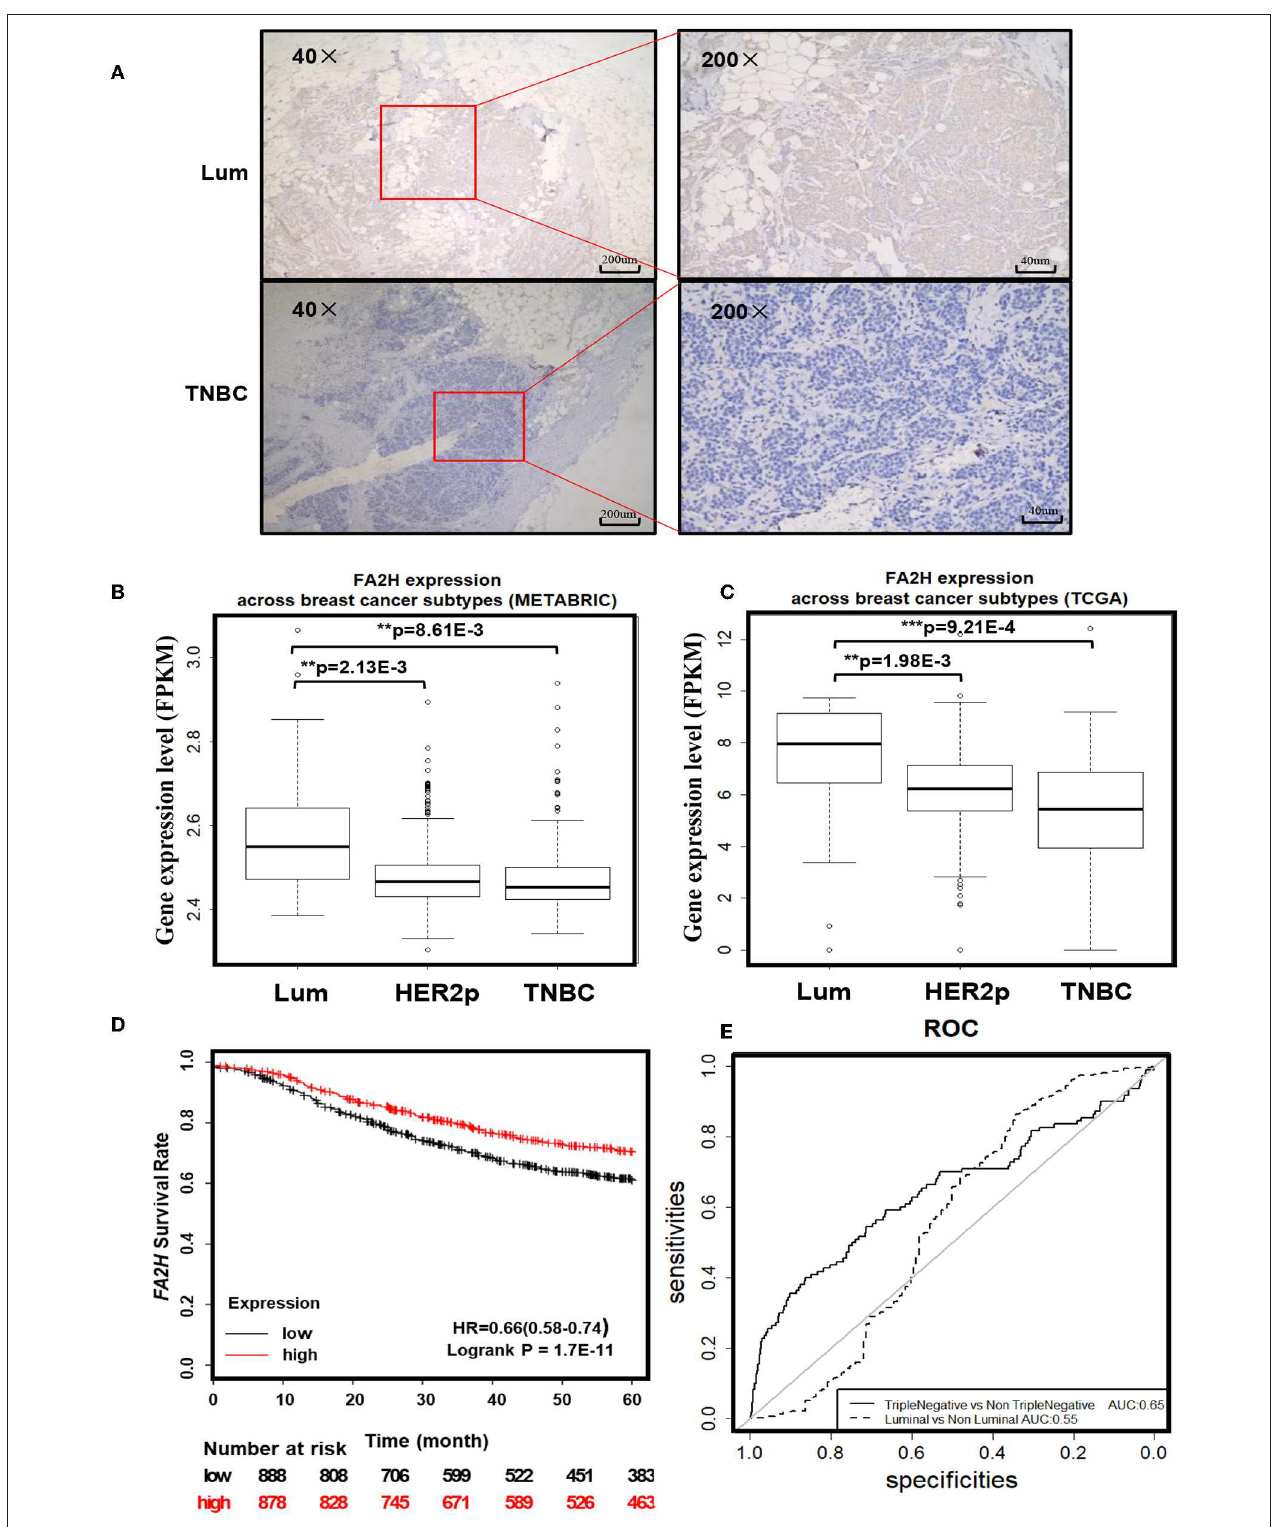
FIGURE 2 | Clinical evidence suggesting potential tumor suppressive roles of FA2H. (A) IHC staining of FA2H between triple negative and luminal breast tumors. FA2H mRNA expression stratified by breast cancer subtypes using (B) METABRIC data and (C) TCGA data. (D) Kaplan–Meier survival curves evaluating the association of FA2H (probe is 234963_s_at) expression with 5 years’ patient survival in breast cancer patients using KM plotter. (E) Precision and recall curves showing the potential diagnostic value of FA2H in identifying triple negative breast cancers using TCGA data.